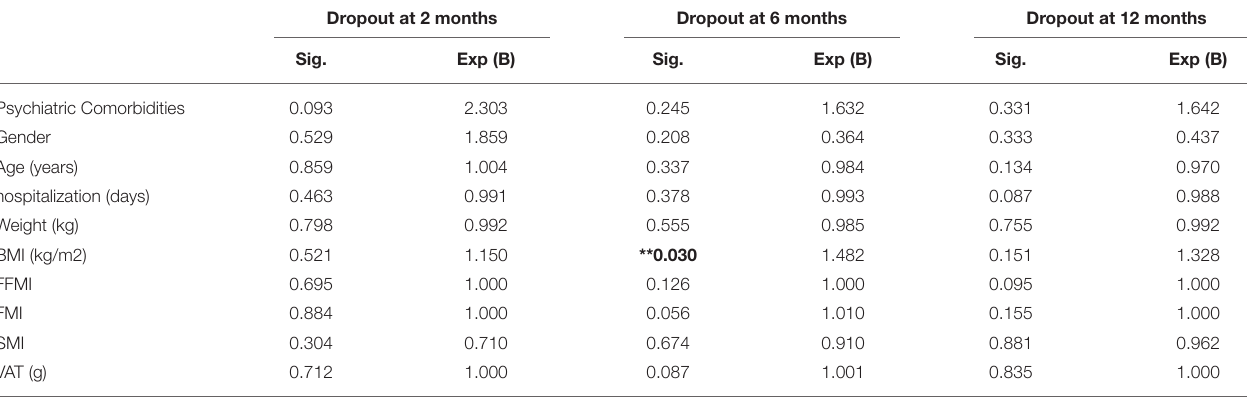
TABLE 5 | Binary regression of dropout risk at 2, 6, and 12 months considering the anthropometric values after the discharge of MRP. Dropout at 2 months